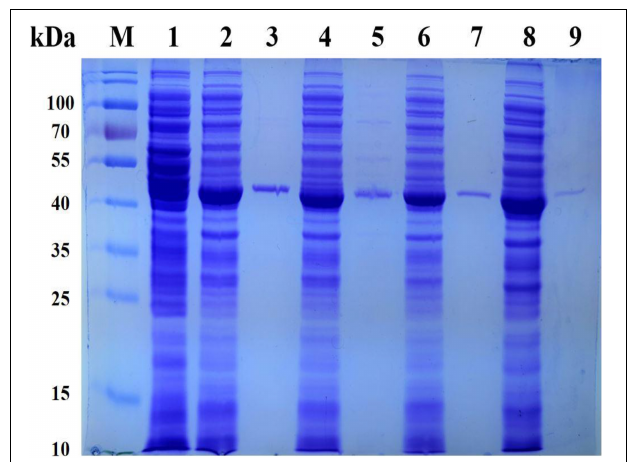
FIGURE 2 | The SDS-PAGE analysis for the representative recombinant leucine dehydrogenase. Lane M, PageRuler Prestained Protein Ladder; lane 1, expressed products of E. coli BL21(DE3)/pET28a; lane 2, crude Tb LeuDH; lane 3, purified Tb LeuDH; lane 4, crude Pf LeuDH; lane 5, purified Pf LeuDH; lane 6, crude Bb LeuDH; lane 7, purified Bb LeuDH; lane 8, crude Cs LeuDH; lane 9, purified Cs